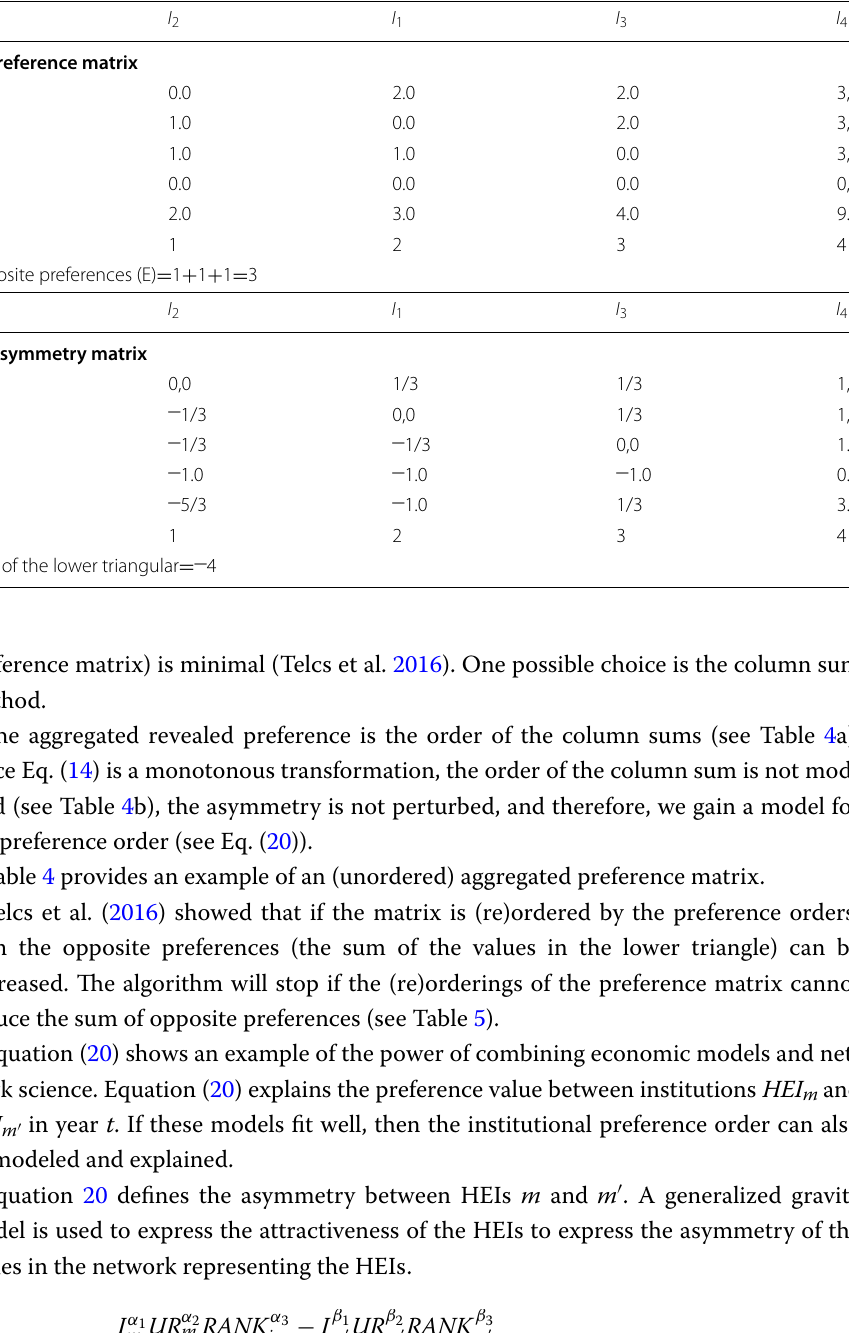
Table 5 The ordered aggregated preference and asymmetry matrices V I 2 I 1 (a) Preference matrix I 2 0.0